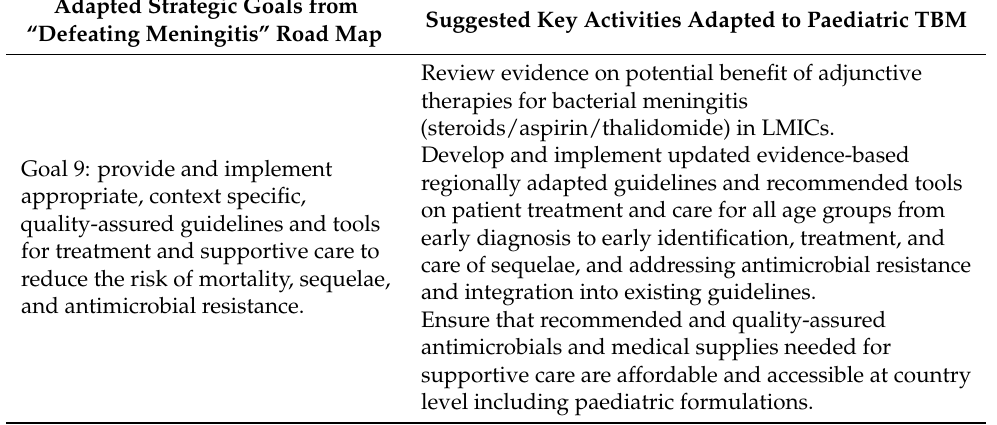
Suggested Key Activities Adapted to Paediatric